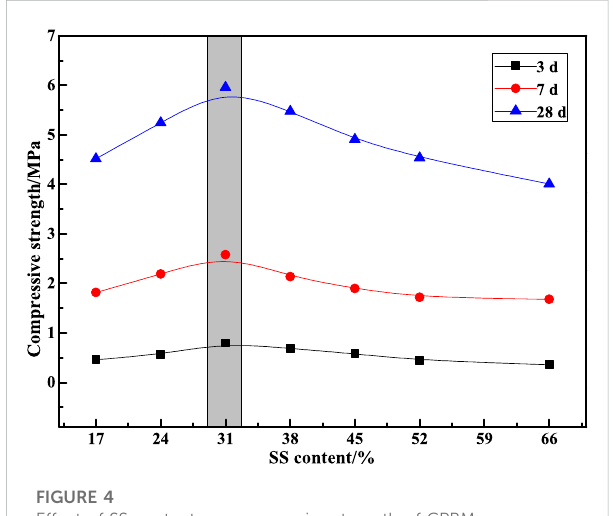
FIGURE 6 Effect of PMC on slump of